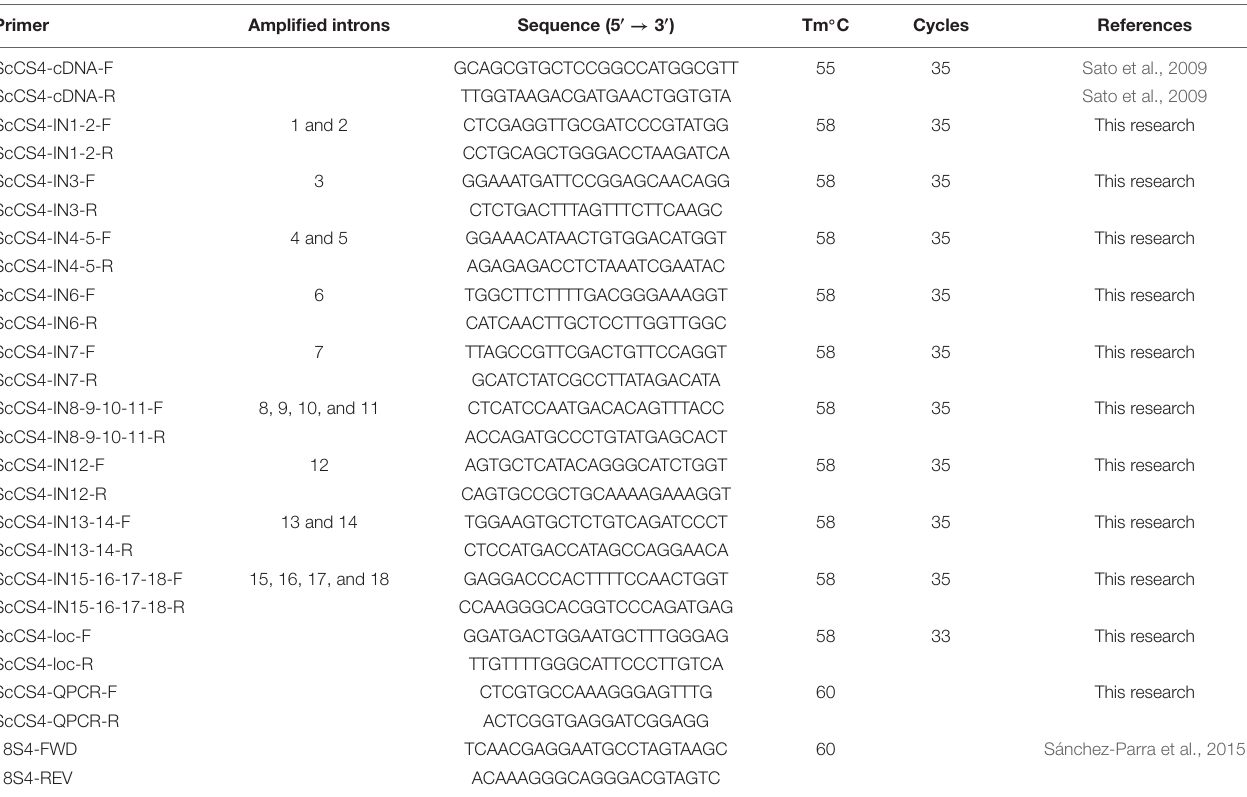
TABLE 2 | Sequences of the primers used in this work, annealing temperature (Tm) and number of cycles used in the PCR. Primer Amplified introns Sequence (5 (cid:48) → 3 (cid:48)